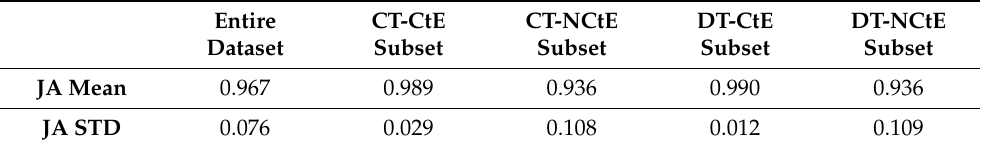
Table 9. Trap segmentation performance results: Mean and STD Jaccard index values between the obtained segmentation mask (after polygonal approximation) and the respective ground truth annotation. CtE—controlled environment, NCtE—non-controlled environment, CT—chromotropic trap; DT—delta